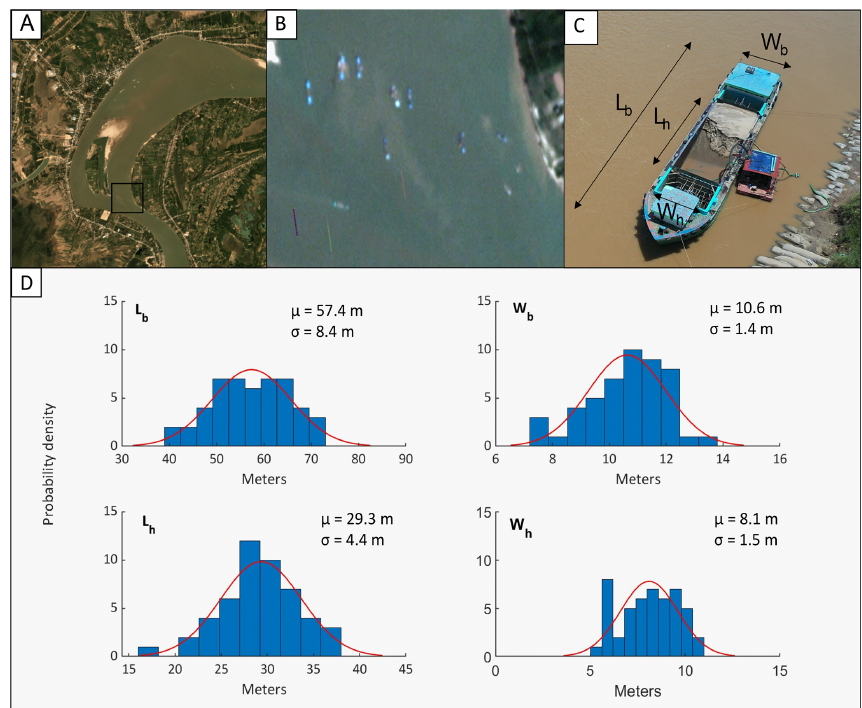
Figure 2. (a) Example PlanetScope monthly composite image of a stretch of the Mekong River from December 2018 (Planet Team, 2018). The square highlights the area depicted in (b) . (b) Zoomed in area of PlanetScope imagery (Planet Team, 2018) for the Mekong showing how mining vessels are identifiable within the satellite imagery. (c) Dimensions of mining vessels recorded including the boat length ( L b ), the boat width ( W b ), the hold length ( L h ), and the hold width ( W h ). These latter two dimensions are important for the calculation of extraction volumes as they define the volume of sand each boat can transport when fully laden. Image is the authors own. (d) Estimated dimensions of the mining vessels active on the Mekong taken from Google Earth imagery © Google Earth. In total, 50 boats were measured and dimensions were recorded as depicted in (c) ( µ : mean; σ : standard